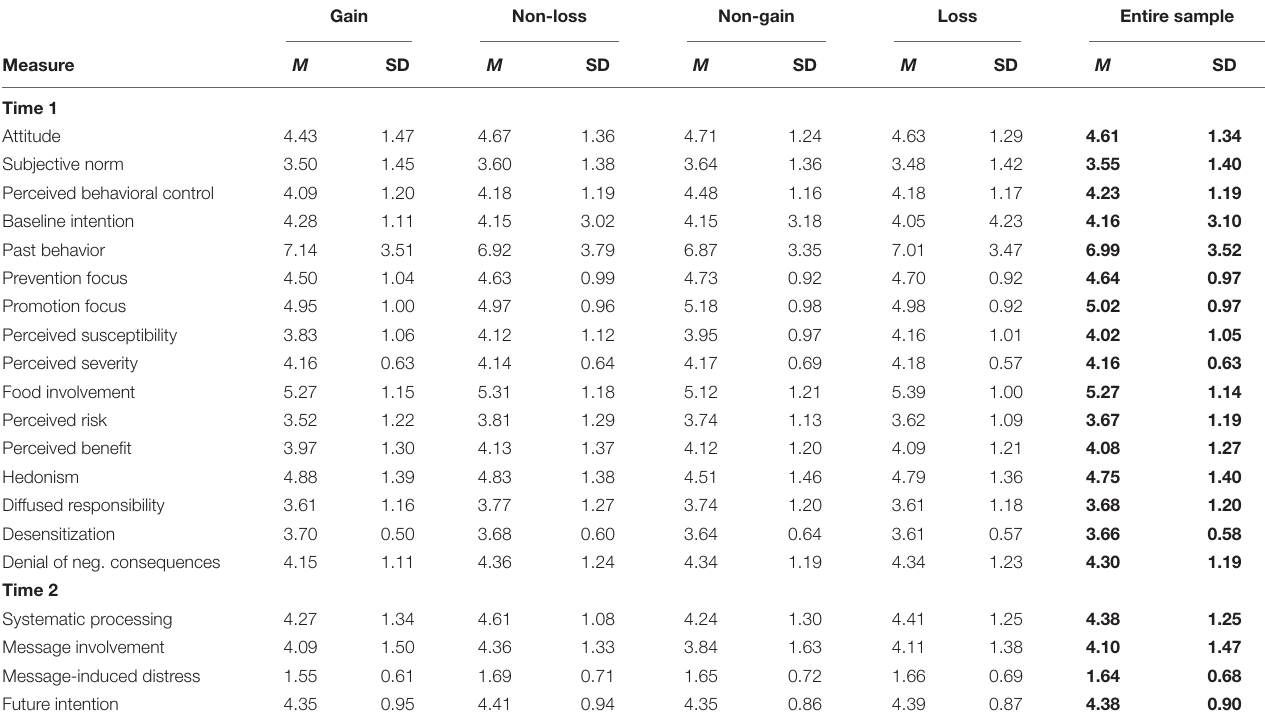
TABLE 1 | Means and standard deviations of the study measures in the four message conditions. Gain Non-loss Non-gain Loss Entire